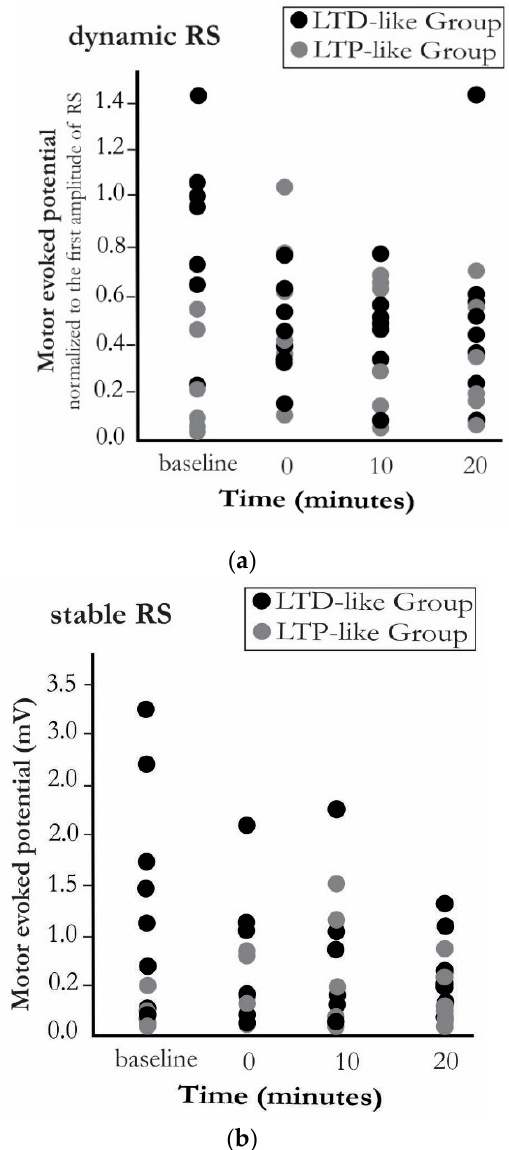
Figure 3. Scatter plot indicating ( a ) the dynamic RS component and ( b ) the stable RS component in all subjects. The low between-group and high within-group homogeneity can be observed in stable RS following applying the PAS intervention, whereas this is not evident for the dynamic RS.